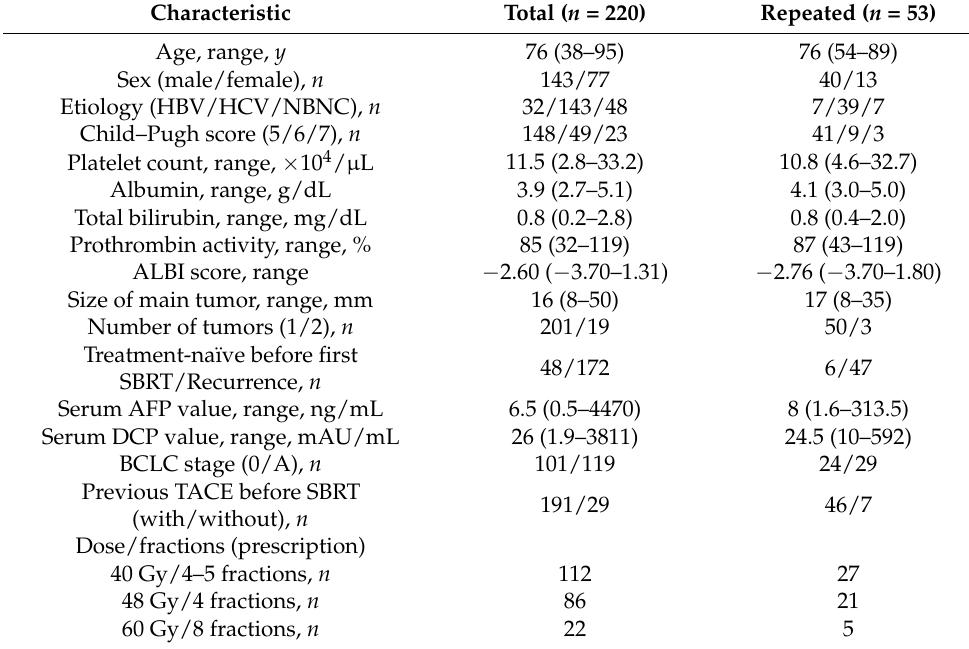
Values represent median (range) or number of patients. HBV—hepatitis B virus infection; HCV—hepatitis C virus infection; NBNC—non-B, non-C viral hepatitis; ALBI—albumin-bilirubin; AFP—alpha-fetoprotein;